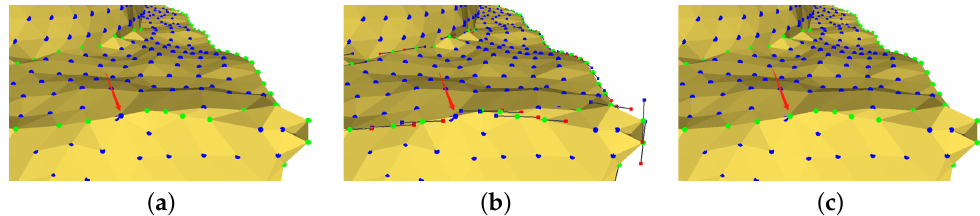
Figure 4. Weak feature point recognition: ( a ) initially recognized feature points; ( b ) eigenvectors of the tensor matrix at each feature point; and ( c ) weak feature points are